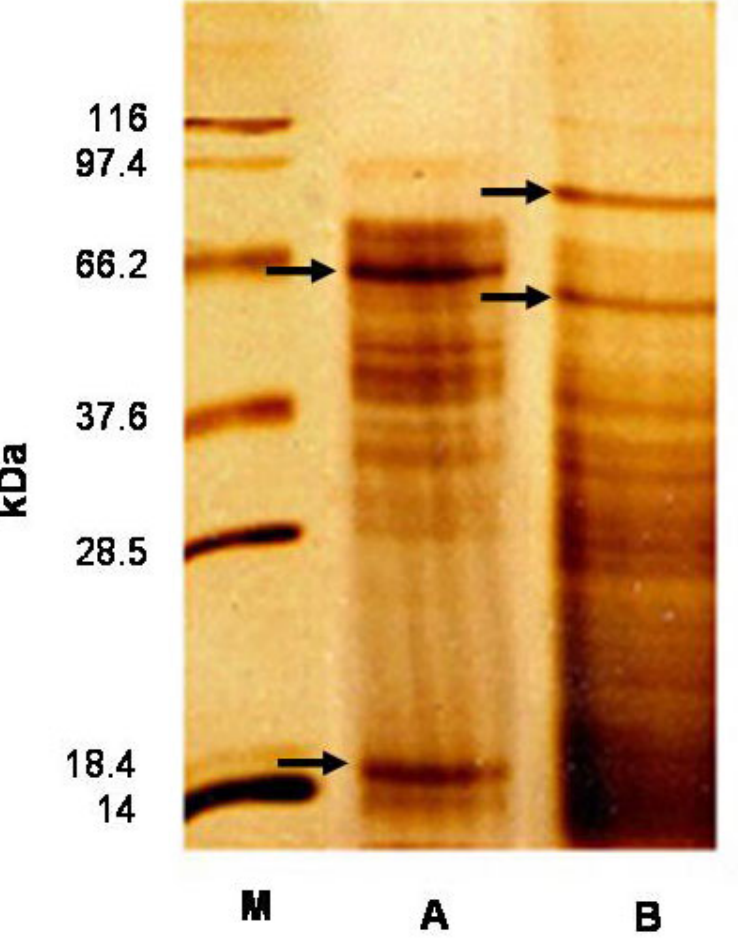
Figure 1. Sodium dodecyl sulfate polyacrylamide gel electrophoresis (SDS-PAGE) of the antigen preparations. Column M: molecular weight standards; column A: exoantigen extract; column B: cytoplasmic